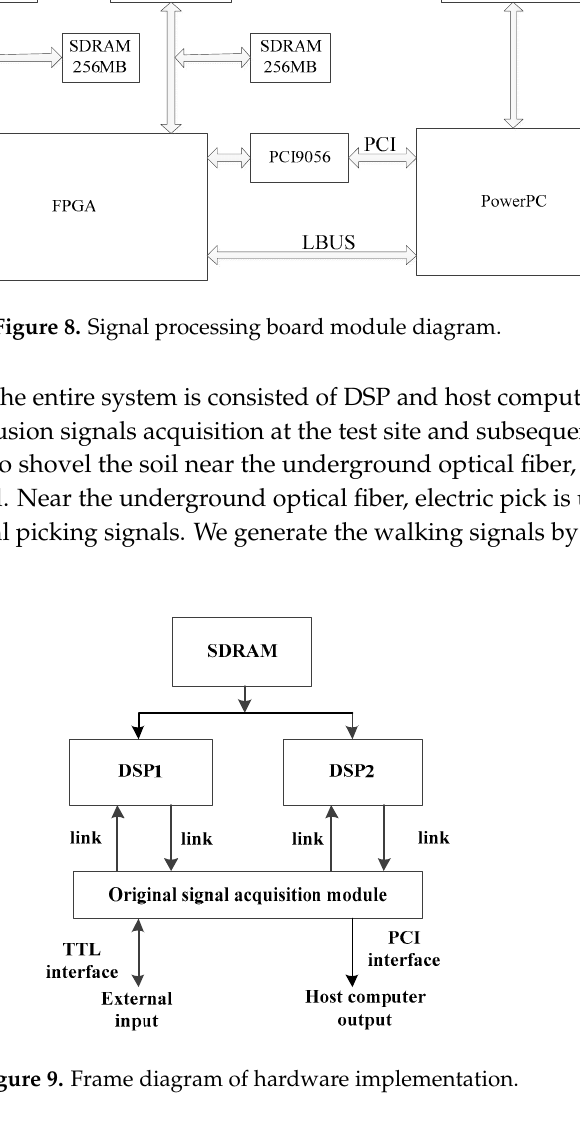
Figure 10. Structure diagram of parallel processing. 3.2. Experiment Analysis of Actual Data To verify the algorithm, we designed experiments to collect actual data in Shangweidian Village, Mentougou District, Beijing. The tester takes four kinds of actions of mechanical drilling, mechanical picking, walking and picking respectively. Each action is divided into three groups and lasts for 2 min. The size of each group of data is 122,880 rows and 45 columns. In order to observe the detection and identification results, the collection of data is performed in a specific geographical area. It is evident from the results that the signals are mainly concentrated in columns 41 and 42. The abscissa represents the locations and the distance between adjacent columns is 16 m. The ordinate represents time and the unit is second. The number of false alarms is the major factor for the detection. For the